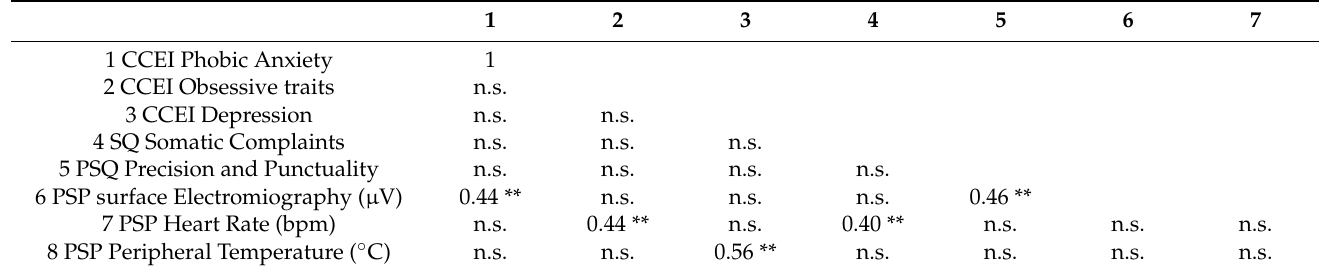
Table 5. Relationships between variables in the whole sample. Legend: ** p < 0.01. CCEI =